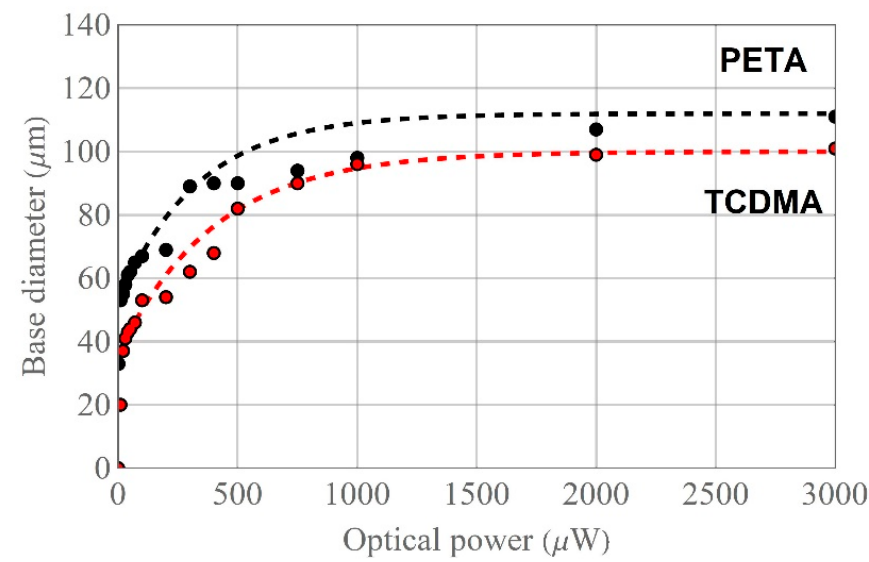
Figure 7. Microtip base diameter vs. optical power of VIS laser with Eosin Y / amine PIS on the gradient-index MMF with the mixture based on monomers: PETA (black dots) and TCDMA (red dots) for t = 60 s with respective approximation curves (dashed lines).